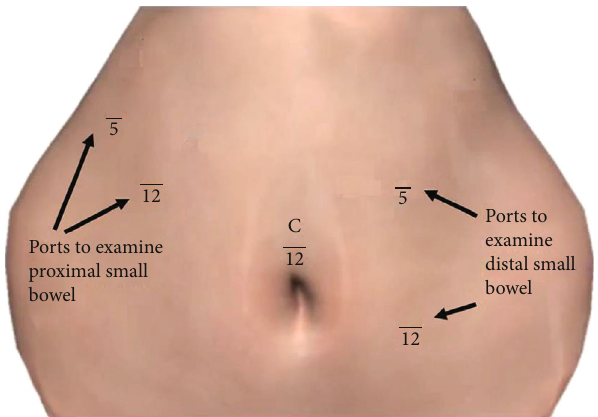
Figure 6: Port placement for laparoscopic examination of small